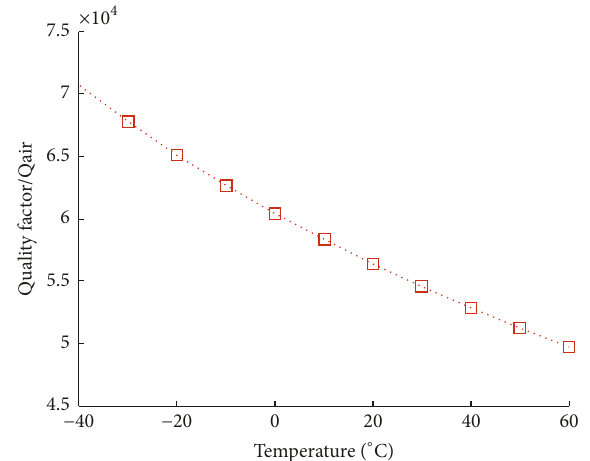
versus temperature T at the pressure of air